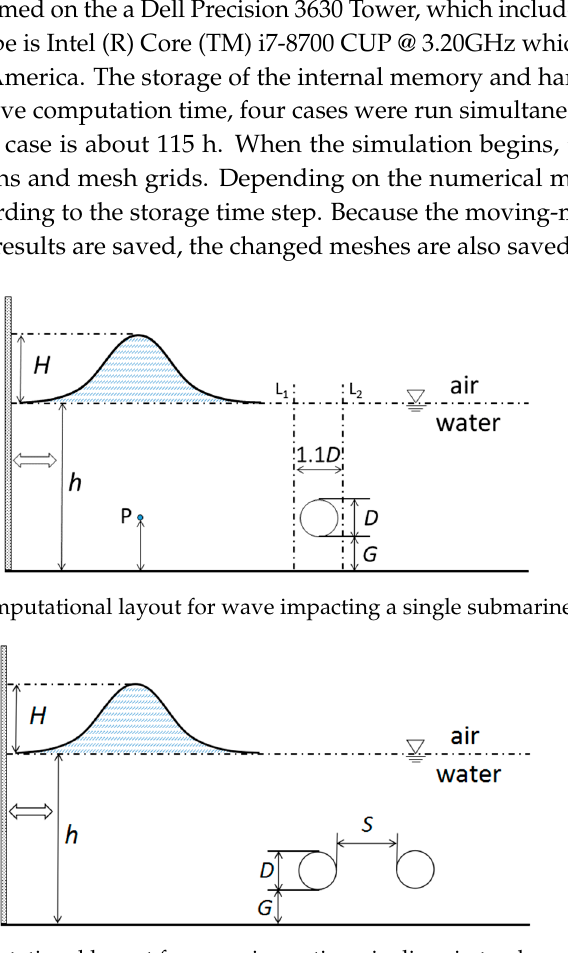
Figure 9. Computational layout for wave impacting pipelines in tandem arrangement.